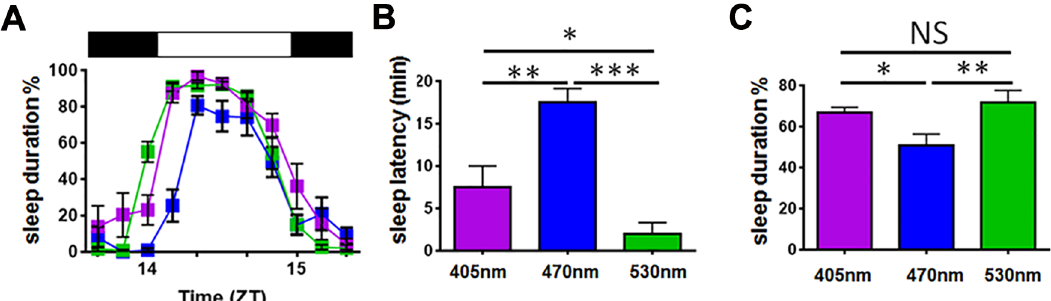
Fig 1. Wavelength-dependent effects on light on sleep induction and sleep duration. ( A ) Mice exposed to different wavelengths (405 nm violet, 470 nm blue, or 530 nm green) for 1 hr at ZT14 exhibited differences in sleep onset and sleep duration. ( B ) Sleep induction is delayed in response to blue light exposure. One-way ANOVA for wavelength, F (2.23) = 18.791, p (cid:1) 0.001. Posthoc Tukey violet versus blue p = 0.003, violet versus green p = 0.041, blue versus green p (cid:1) 0.001. ( C ) Total sleep duration during the 1 h light pulse is reduced in response to blue light. Data plotted as mean percentage ± SEM ( n = 8 – 10/group). Horizontal black-white-black bar illustrates the light pulse condition from ZT14 until ZT15. One-way ANOVA for wavelength, F (2.23) = 4.391, p = 0.024. Posthoc Tukey violet versus blue p = 0.046, violet versus green p = 0.517, blue versus green p = 0.008. Statistical differences indicated by *** p (cid:1) 0.001, ** p (cid:1) 0.01, * p (cid:1) 0.05, NS = not significant. The data used to make this figure can be found in S1 Data.